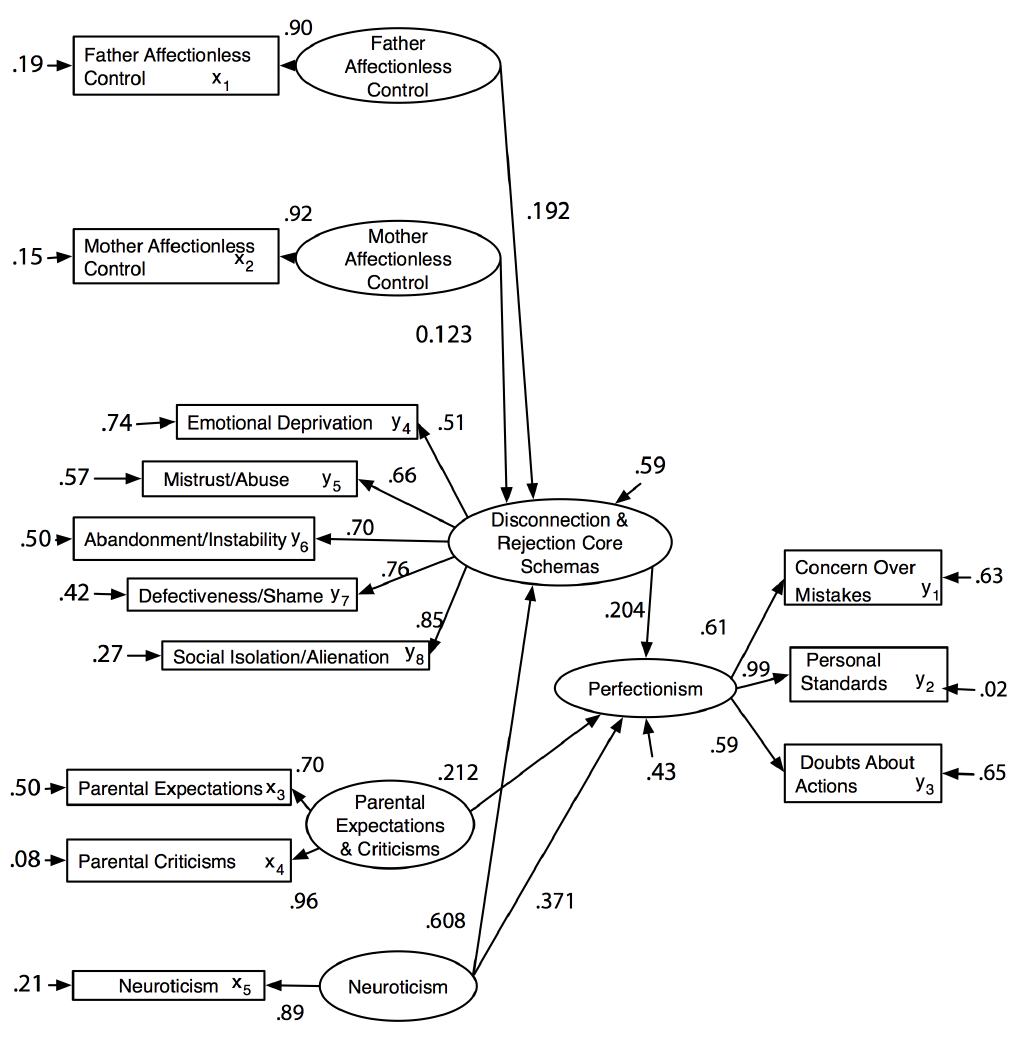
Figure 3. The measurement and structural components of the final six-pathway model.